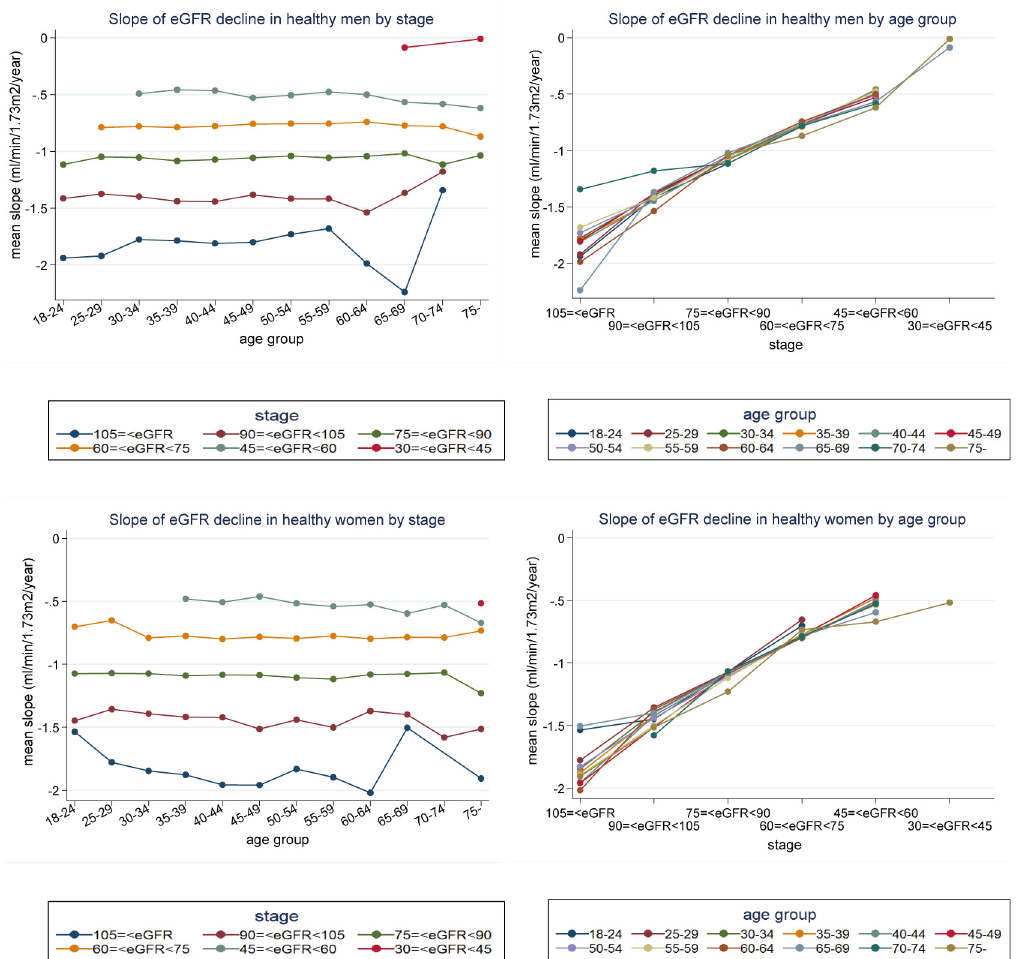
Fig 3. Graphs of the rate of eGFR decline in healthy men and women by renal stage and age group. The mean slope for each stratified component by gender, age and renal stage in Tables 3 and 4 is plotted on the y-axis, and age group and renal stage are plotted on the x-axis. When the slope was stratified by renal stage and gender, all lines ran almost parallel with the x-axis showing age group (left side).When the slope was stratified by age group and gender, all lines almost overlapped (right side). There was little difference in slope within the same renal stage regardless of age, whereas the slope changed depending on the renal stage. The slope was steeper when baseline eGFR was higher (i.e. better renal function) and shallower when baseline eGFR was lower (i.e. renal stage changed from G1 to